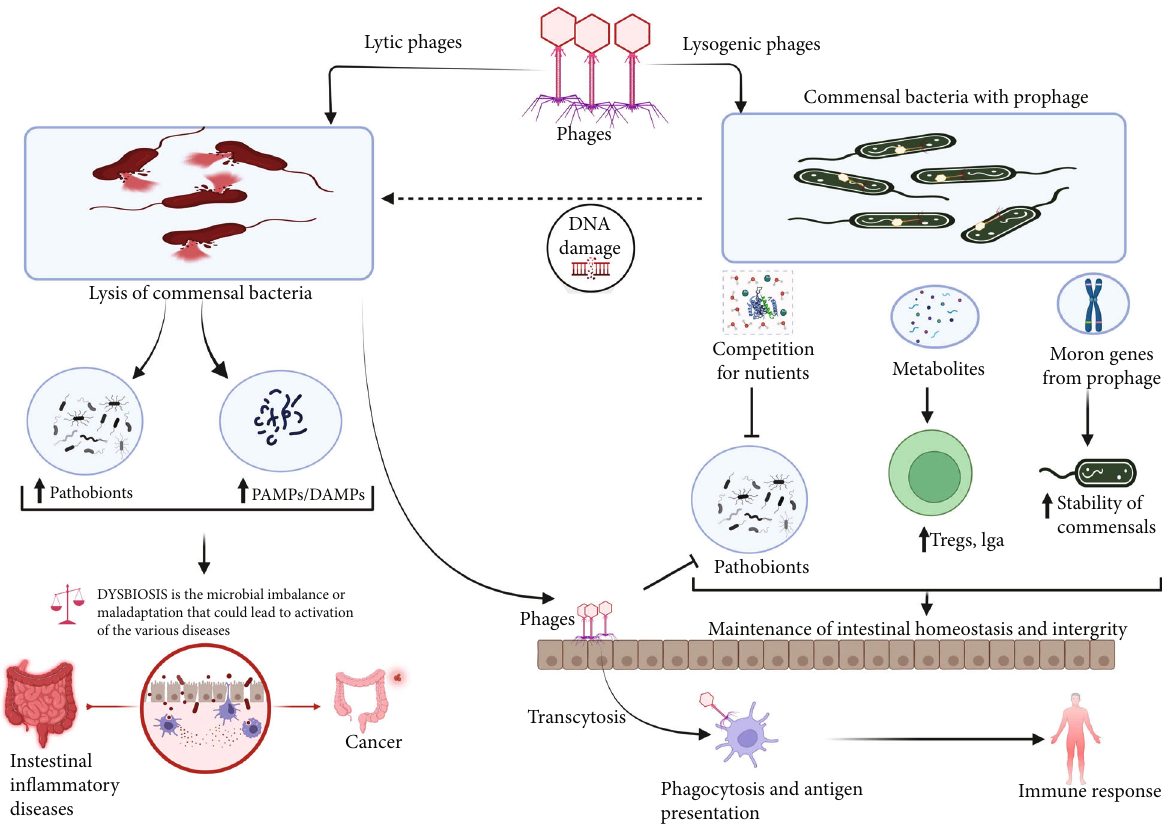
Figure 3: This fi gure illustrates the role of lytic and lysogenic phages in the induction and protection of intestinal dysbiosis and in fl ammation. The lysis of bacteria by lytic phages leads to the release of pathogen-associated molecular patterns (PAMPS) and danger- associated molecular patterns (DAMPS) which trigger the release of proin fl ammatory cytokines leading to intestinal in fl ammation and dysbiosis. However, phages released from lysed bacteria can bind to the intestinal mucosa and protect against pathobionts. Phages can also cross the mucosal barrier by transcytosis and induce local and systemic immune response. On the contrary, commensal bacteria protect the intestinal mucosa from pathobionts and helps in the maintenance of intestinal homeostasis and integrity via competition for nutrients with pathobionts, induction of Tregs, IgA. Nevertheless, following stress factors which lead to DNA damage these prophages can become lytic triggering in fl